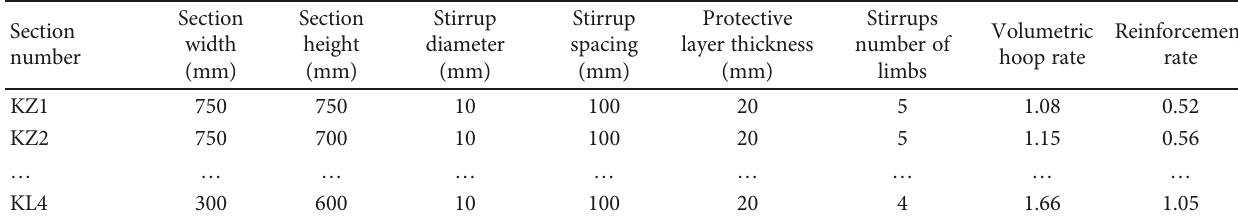
Table 2: Reinforcement information of sections.